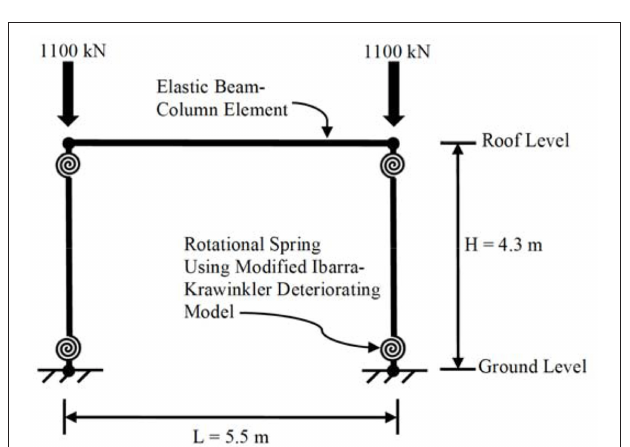
FIGURE 1 | Damping correction procedure (Dowgala, 2013).